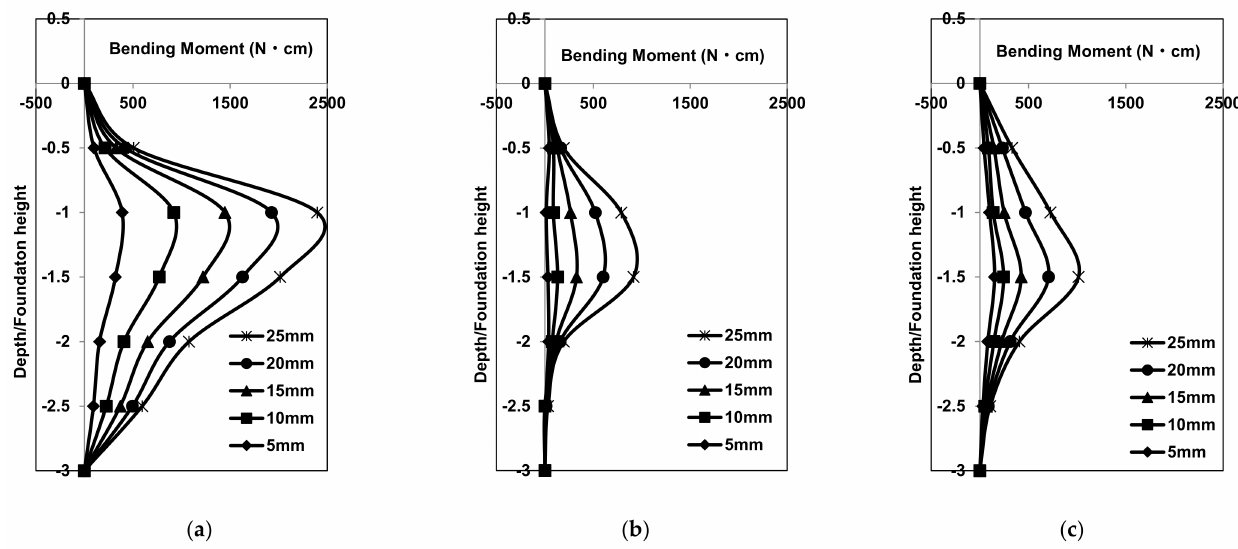
Figure 14. Bending moment by pile position: ( a ) front row; ( b ) back row; ( c ) right-hand